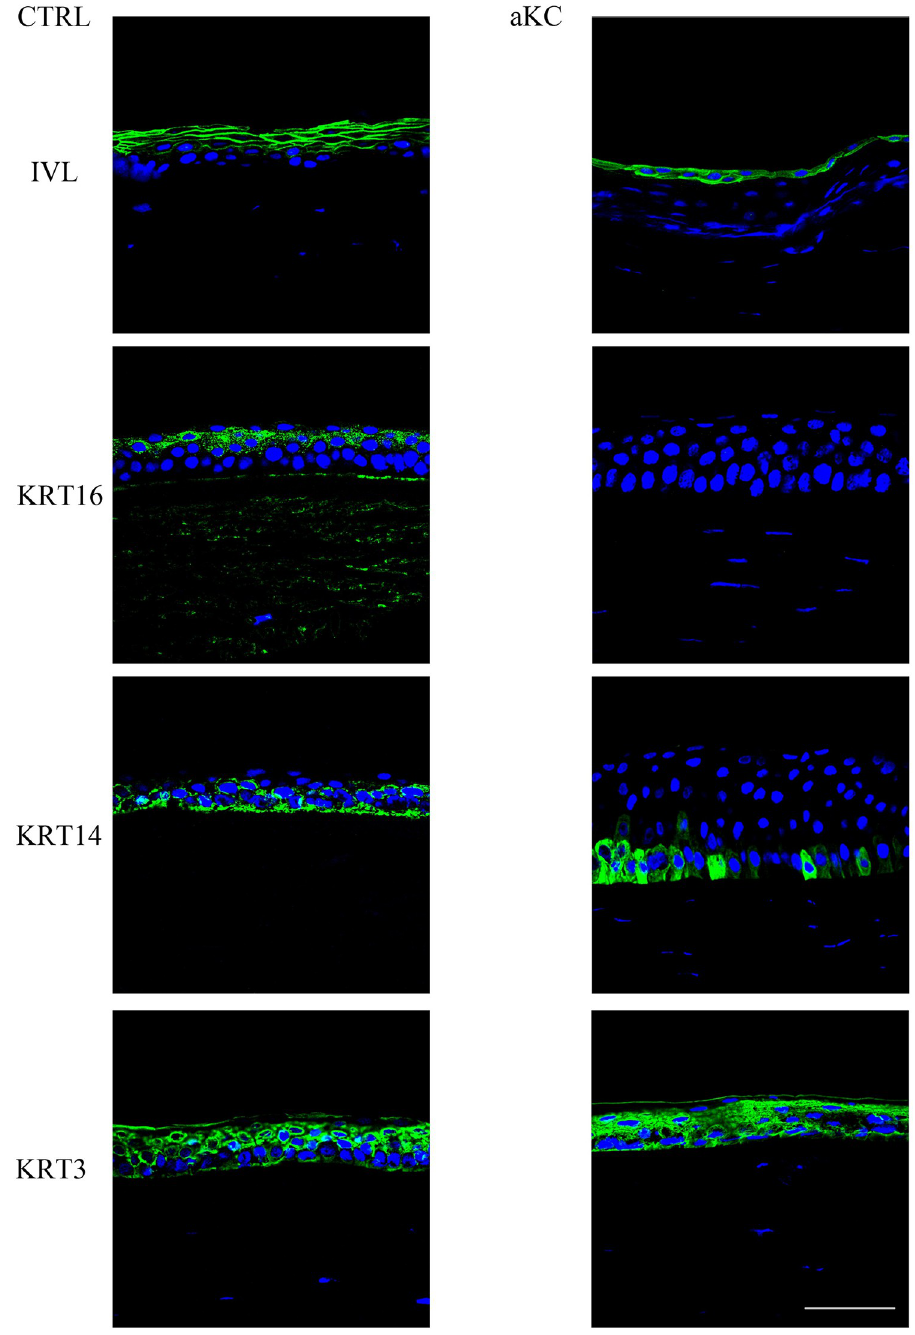
Fig 2. Differentially expressed proteins in advanced KC. Sections of normal (CTRL; n = 3) and advanced keratoconus (KC; n = 3) corneas were analyzed by indirect immunofluorescence (green) with the indicated antibodies. Nuclei were stained with TO-PRO Iodide (blue). Scale bar = 100 μ m.